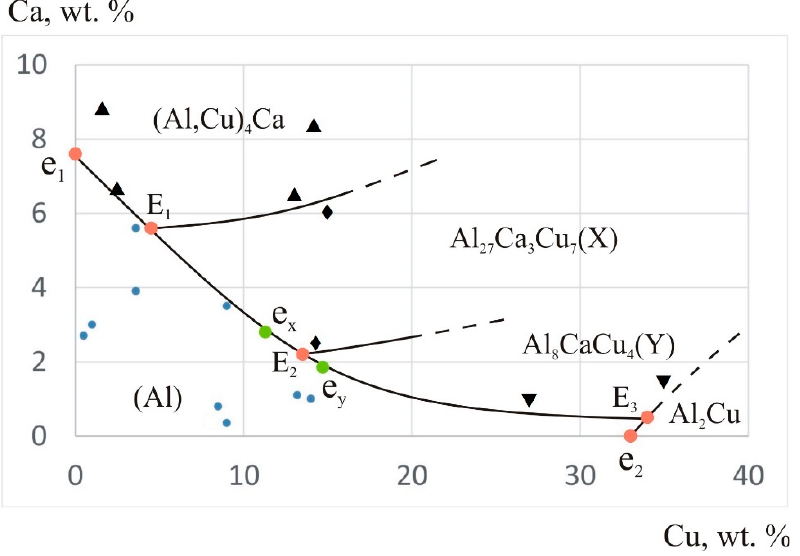
Figure 7. Experimental liquidus projection of the Al-Ca-Cu system in the aluminum corner. The symbols mark the compositions of the alloys for which a specific type of primary crystals is observed. Table 3. Coordinates of invariant phase